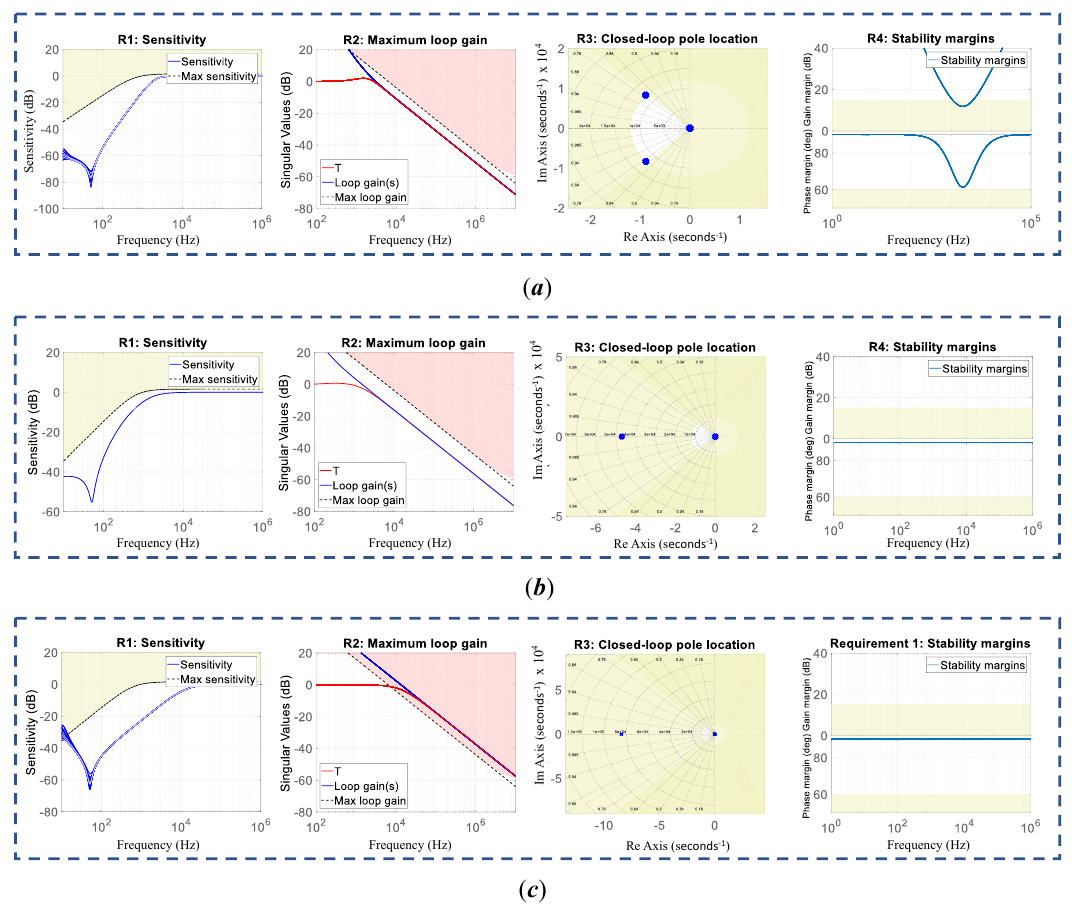
Figure 8. Closed-loop specifications’ verification for the i q